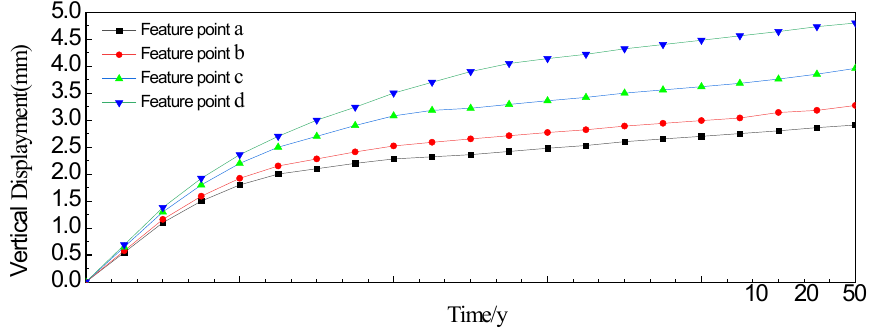
Figure 19. Settlement of each characteristic point when t = 50 years.